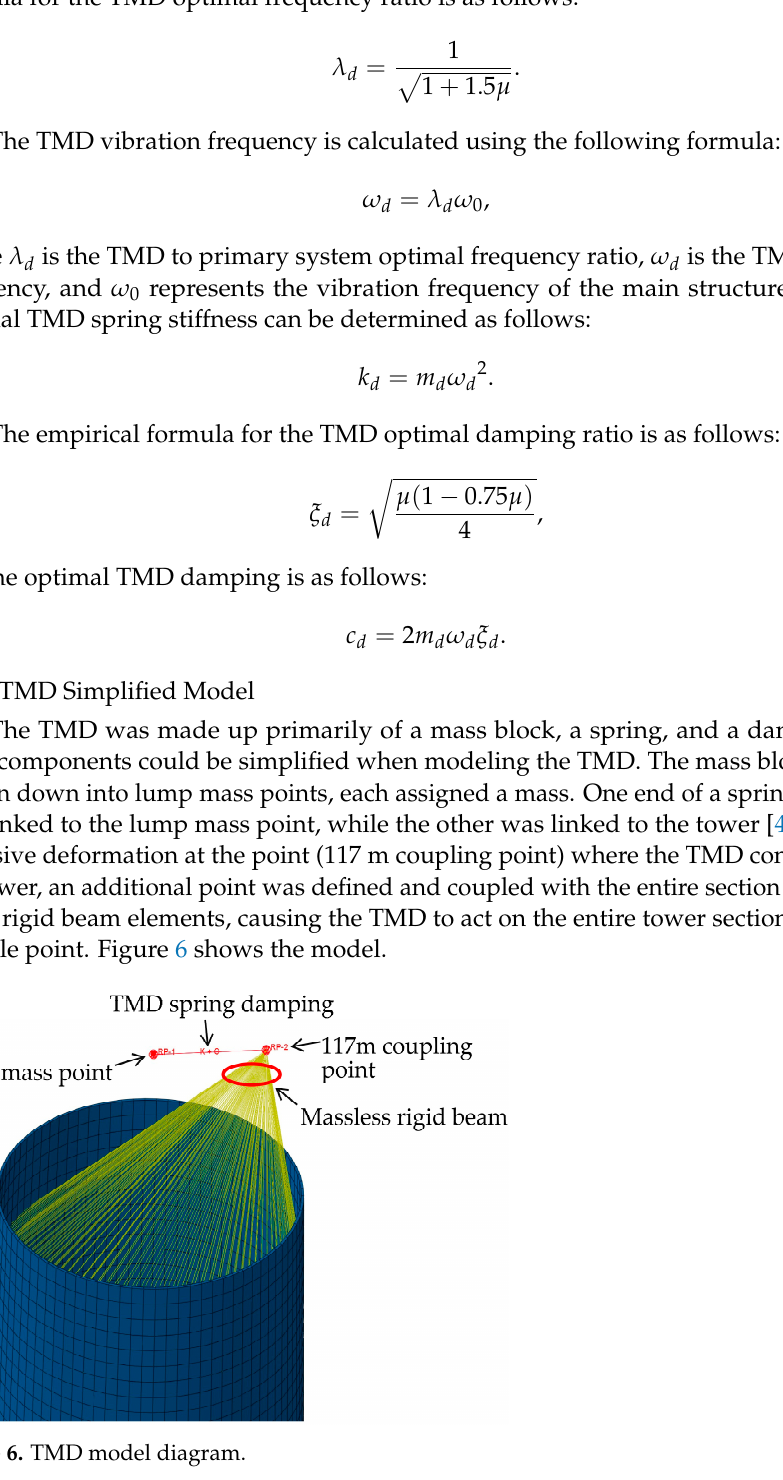
Table 1. Effect of the wind turbine on the tower.